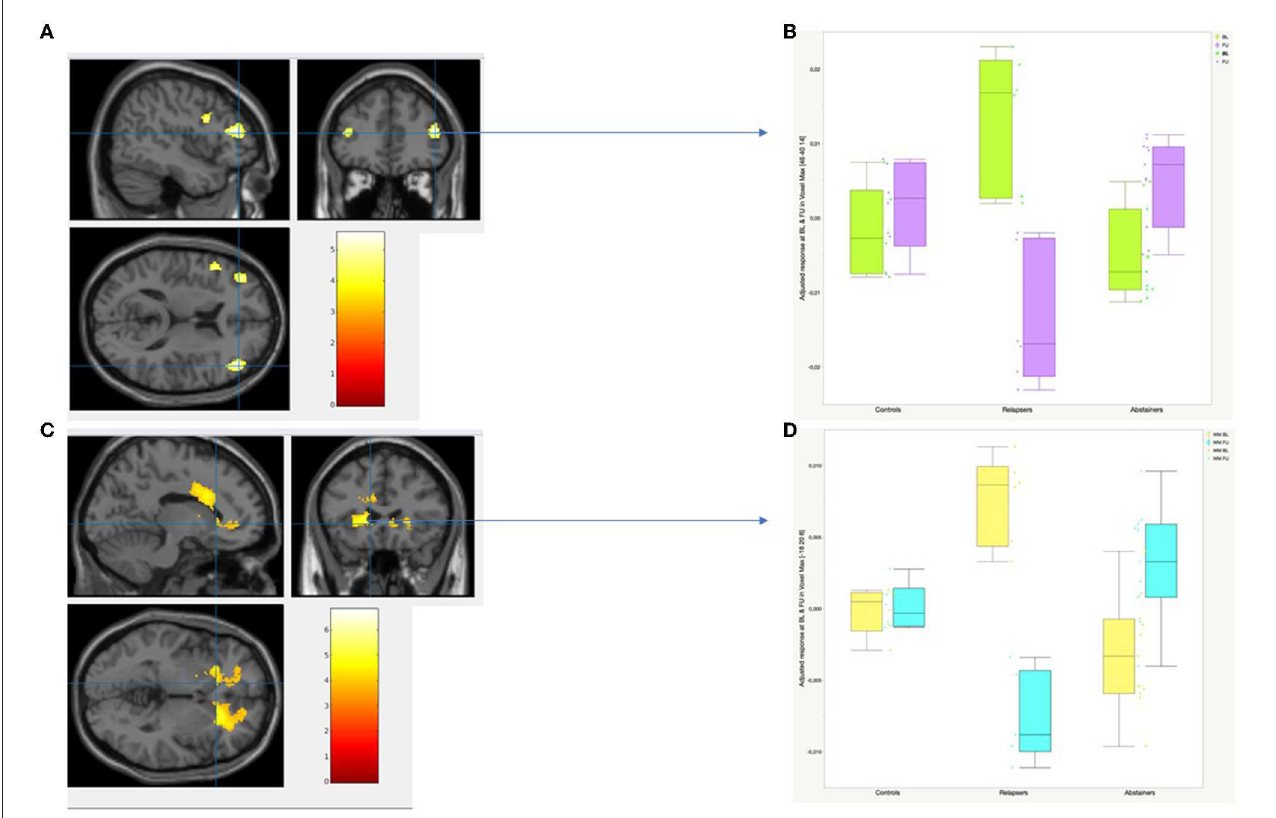
FIGURE2 Longitudinal gray matter and white matter analysis: Time by Group Interaction. (A) 2D views of GM regions showing significant time x group interaction. The height threshold was set at p < 0.001 uncorrected and the extent threshold at p < 0.05 uncorrected. (B) Individual plots and adjusted voxel values at baseline (boxplots in green) and at follow-up (boxplots in purple) in control, relapser and abstainer groups at the highest peak-voxel detected by the Time by Group Interaction in GM (right middle frontal gyrus, BA 46: MNI coordinates: x = 46, y = 40, Z = 14). (C) 2D views of WM regions showing significant time x group interaction. The height threshold was set at p < 0.001 uncorrected and the extent threshold at p < 0.05 uncorrected. (D) Individual plots and adjusted voxel values at baseline (boxplots in yellow) and at follow- up (boxplots in blue) in control, relapser and abstainer groups at the highest peak-voxel detected by the Time by Group Interaction in WM (Anterior Limb of Internal Capsule: MNI coordinates: x = − 18 y = 20, Z = 8).